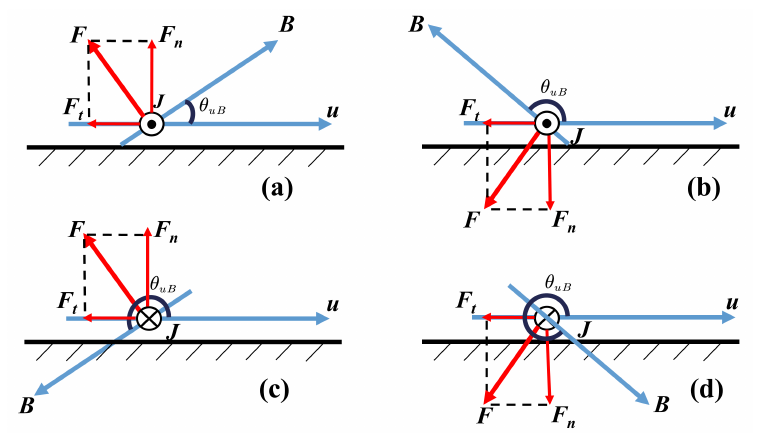
Figure 20. Schematic diagram of the Lorentz force: ( a ) 0 ◦ < θ uB < 90 ◦ . ( b ) 90 ◦ < θ uB < 180 ◦ . ( c ) 180 ◦ < θ uB < 270 ◦ . ( d ) 270 ◦ < θ uB < 360 ◦